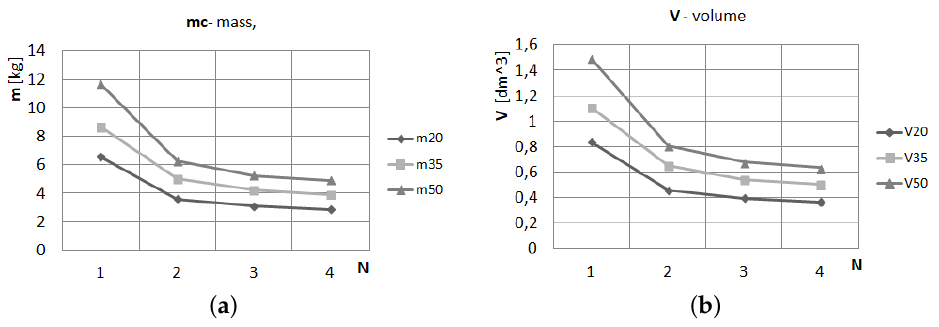
Figure 12. Mass vs. number of discs N ( a ) and volume vs. number of discs N ( b ) for MR clutches T c = 20,35,50 Nm.